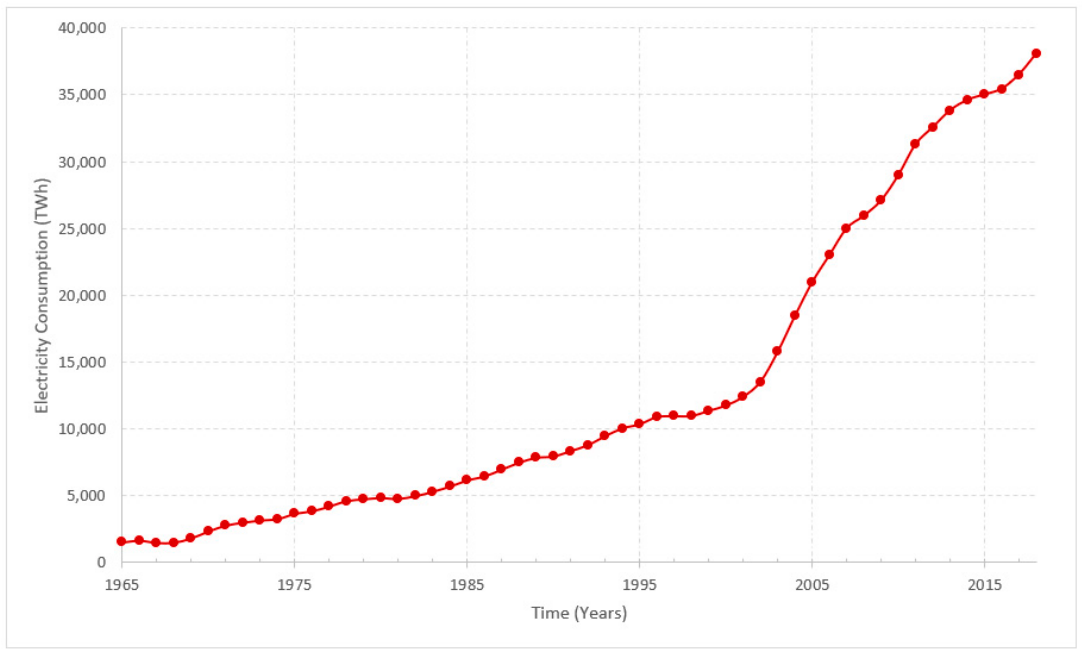
Figure 2. Electricity consumption in China (1965–2018) [18].